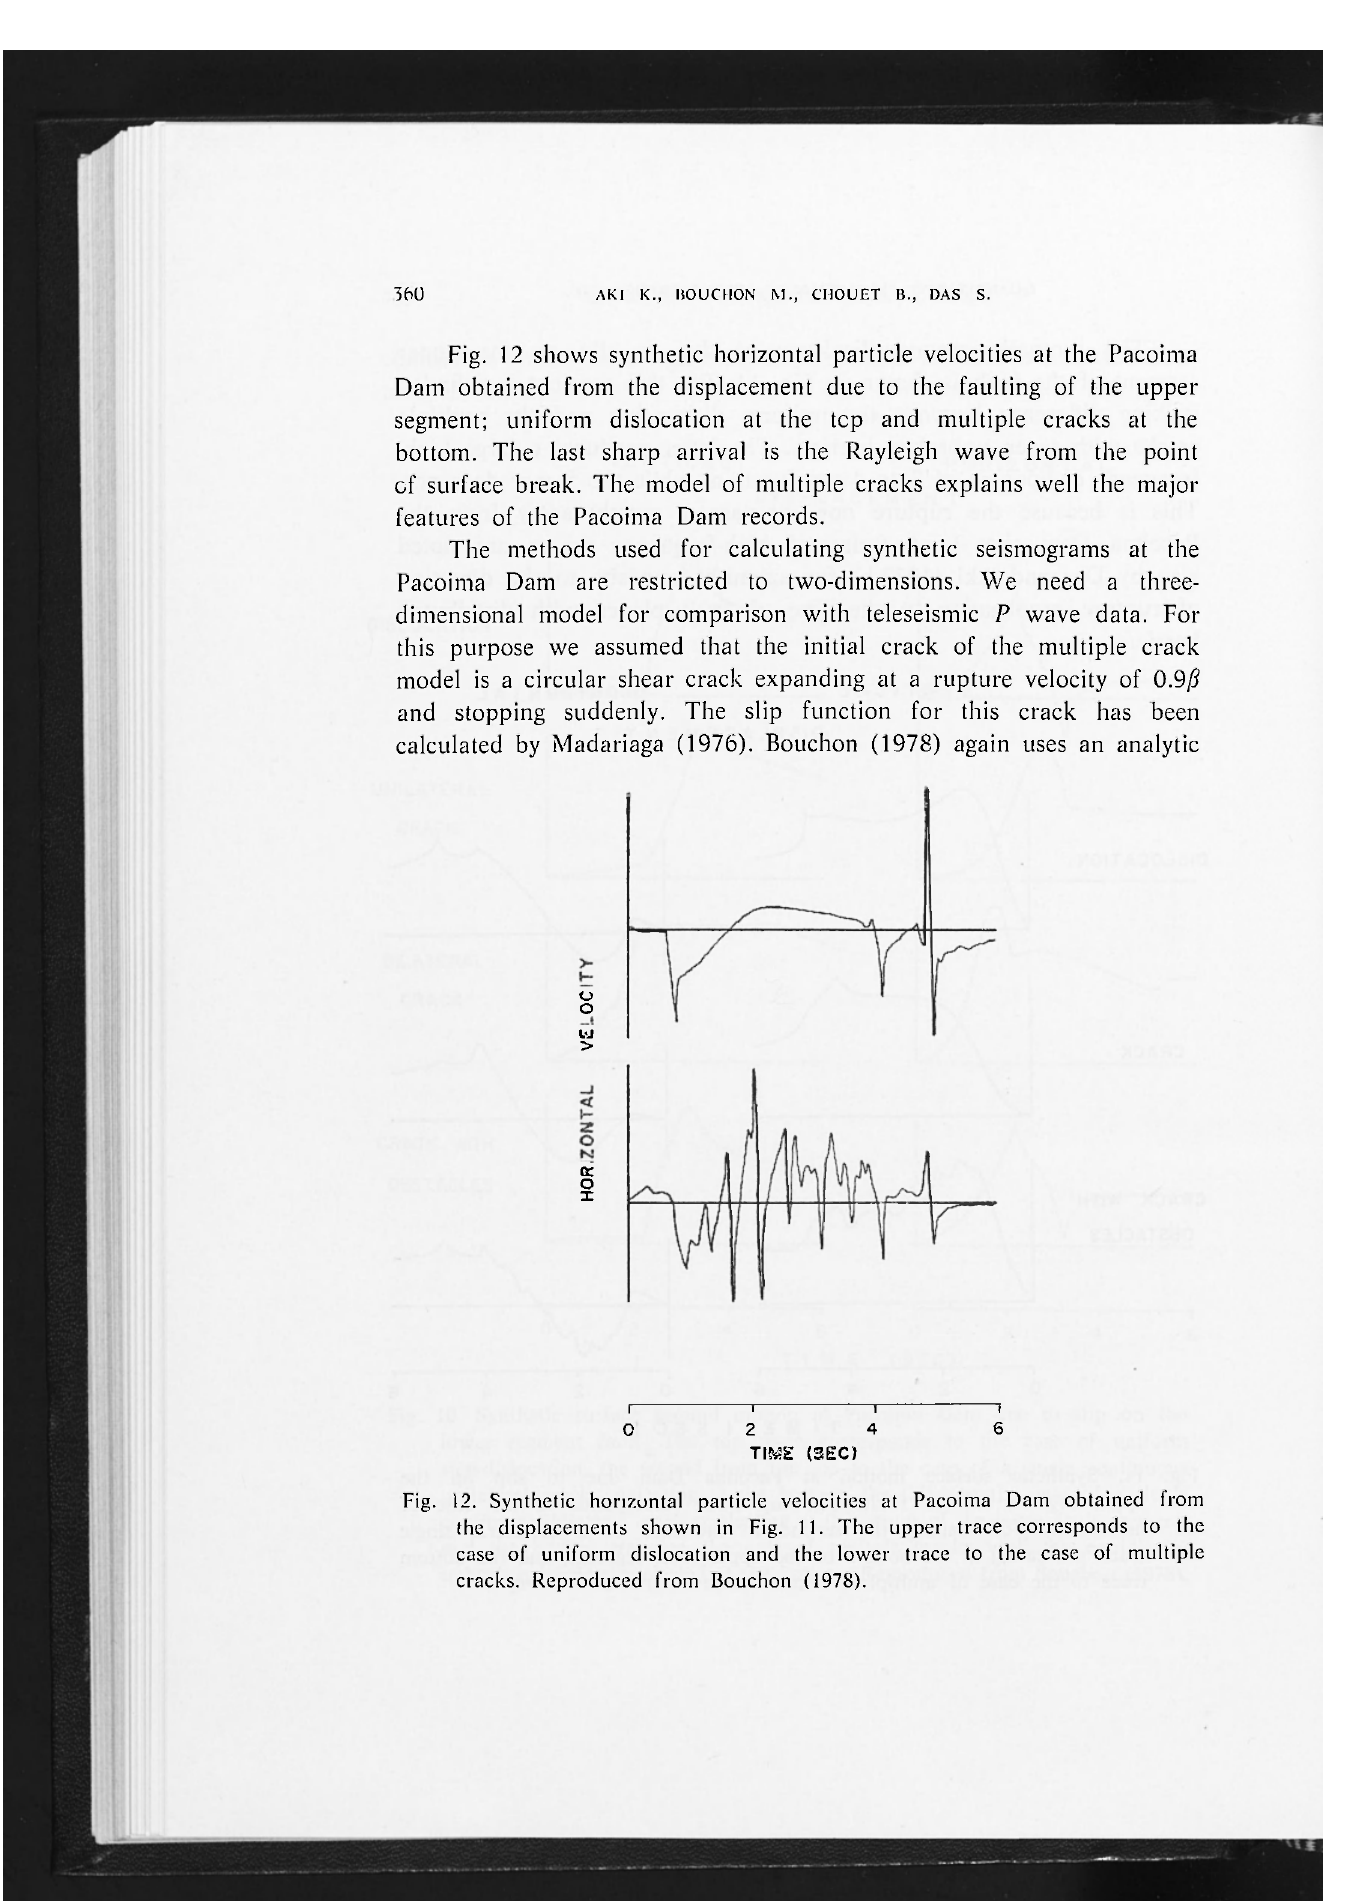
Fig. 12. Synthetic horizontal particle velocities at Pacoima Dam obtained from the displacements shown in Fig. 11. The upper trace corresponds to the case of uniform dislocation and the lower trace to the case of multiple cracks. Reproduced from Bouchon